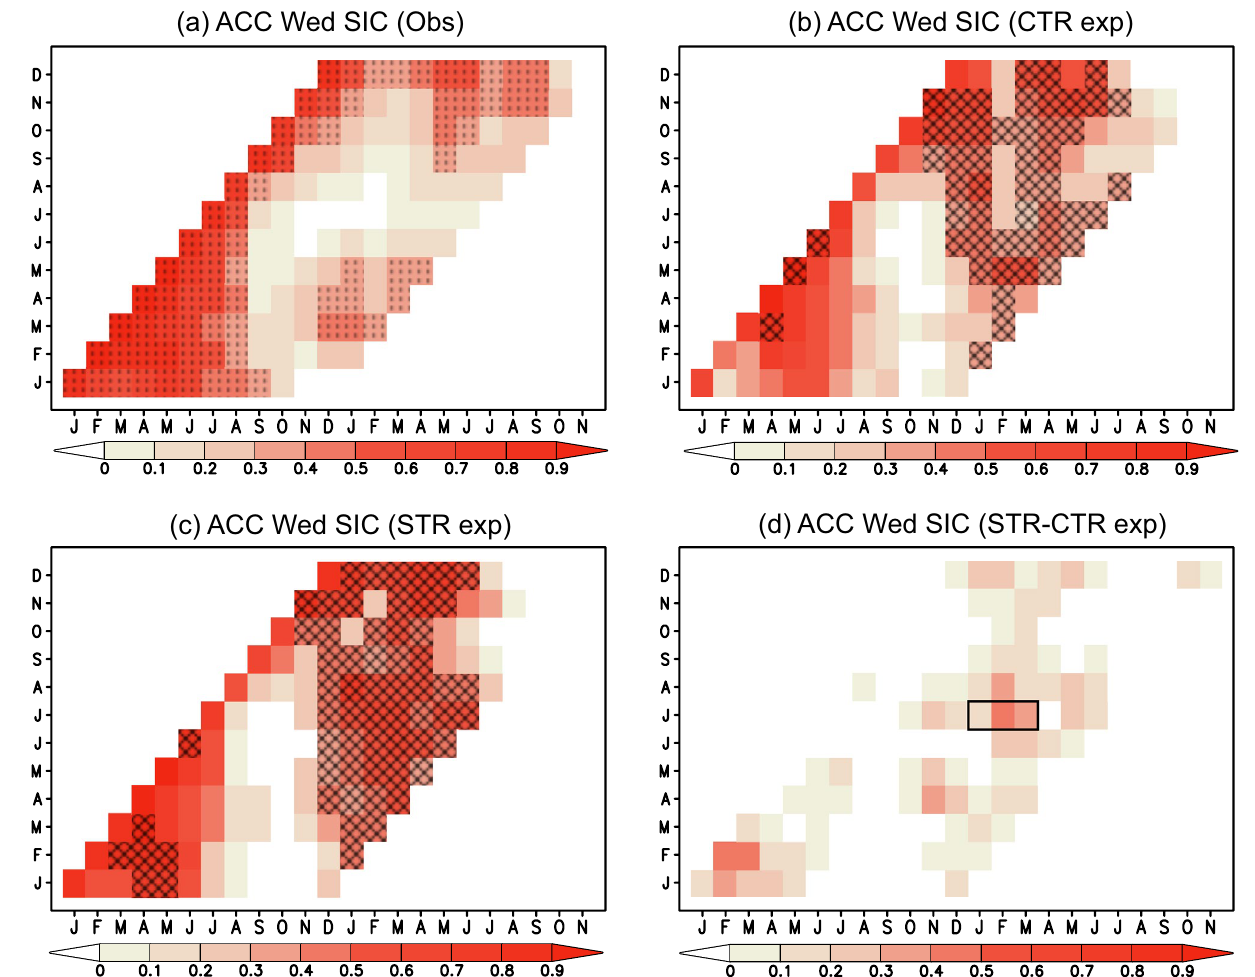
Figure 2. ( a ) Anomaly correlations (ACCs) for the persistence prediction using the observed SIC anomalies averaged in the Weddell Sea (70° S–60° S, 55° W–40° W; see the black boxes in Fig. 6). X-axis denotes predicted months, while Y-axis denotes initial months. Dots indicate correlations that are statistically significant at 90% confidence level using the two-tailed Student’s t -test. ( b ) Same as in ( a ), but for the ACCs between the observed SIC anomalies and the predicted SIC anomalies in the CTR experiment. Hatches indicate correlations above the persistence values that are statistically significant at 90% confidence level using the two-tailed Student’s t -test. ( c ) Same as in ( b ), but for the ACCs using the predicted SIC anomalies in the STR experiment. ( d ) Differences in the ACCs between the STR and CTR experiments, i.e., ( c )–( b ). Black box indicates January–March season of research